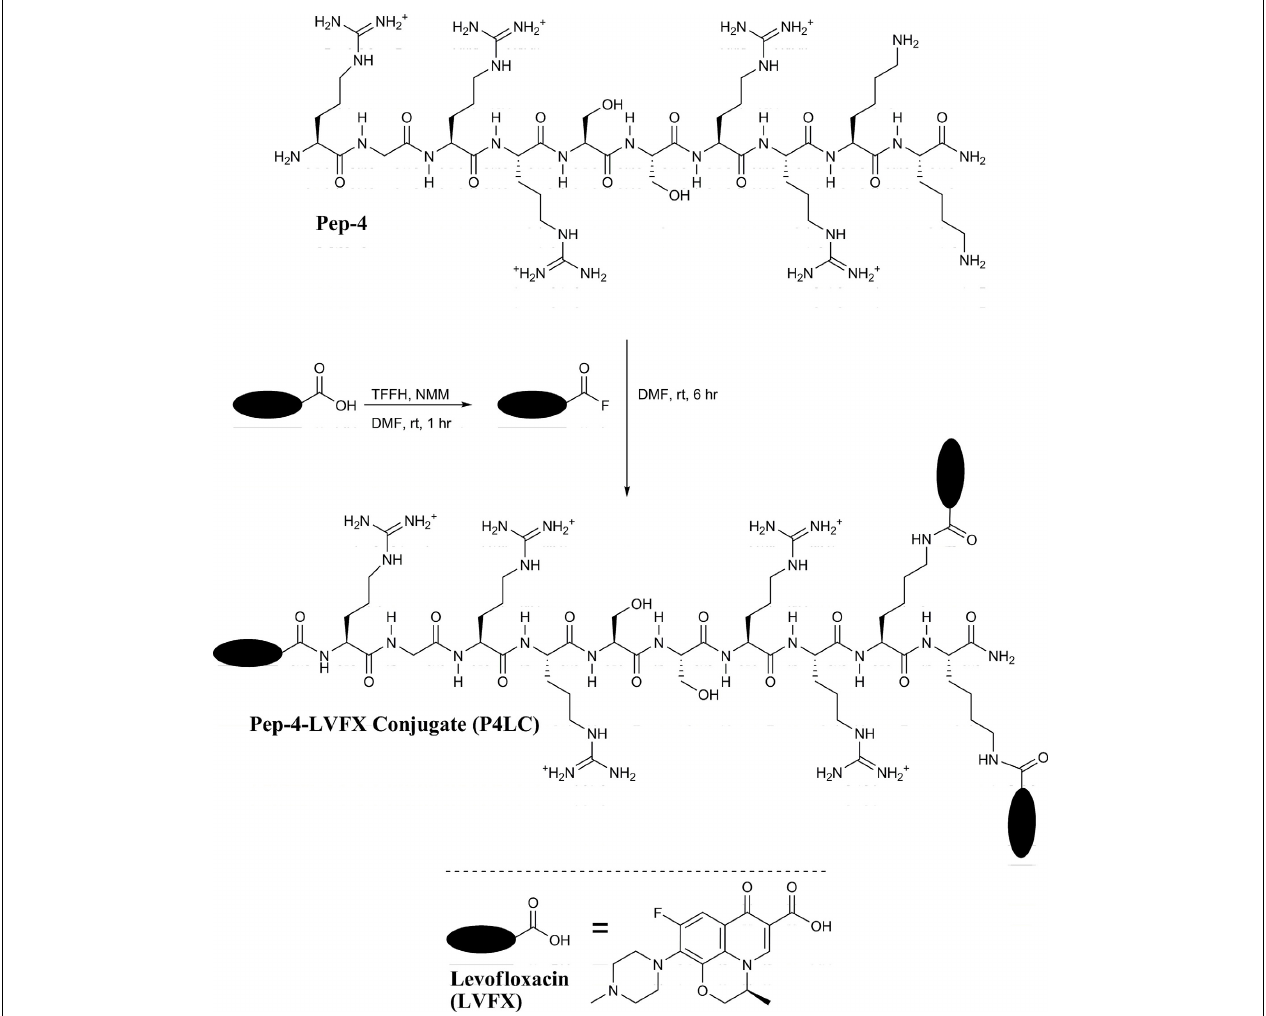
FIGURE 1 | Pep-4 was coupled to LVFX in a two-step, one-pot synthesis. The carboxyl moiety of LVFX was preactivated using TFFH to afford the acyl fluoride. Pep-4 was then added to the activated LVFX reaction mixture to yield P4LC.